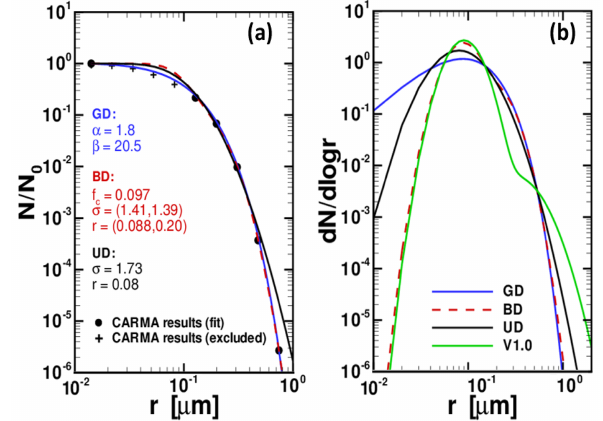
Figure 1. Comparison between gamma size distribution (GD), bi- modal lognormal size distribution (BD) and unimodal normal dis- tribution (UD). (a) Three cumulative size distribution fits as a func- tion of particle radius to the normalized CARMA data at 20km. Blue: GD; red: BD; black: UD. The black dots represent cumula- tive CARMA data. Data points shown as ( + ) were excluded from the fit. (b) Differential size distributions derived from the fitted pa- rameters shown in (a) . For comparison, the size distribution used in V1.0 (green) is also shown. Among these size distributions, the V1.0 function has the largest d N/ dlog r value at 0.1µm and the smallest d N/ dlog r value at 0.3µm. The phase functions derived from the V1.0 and GD are shown in Fig.